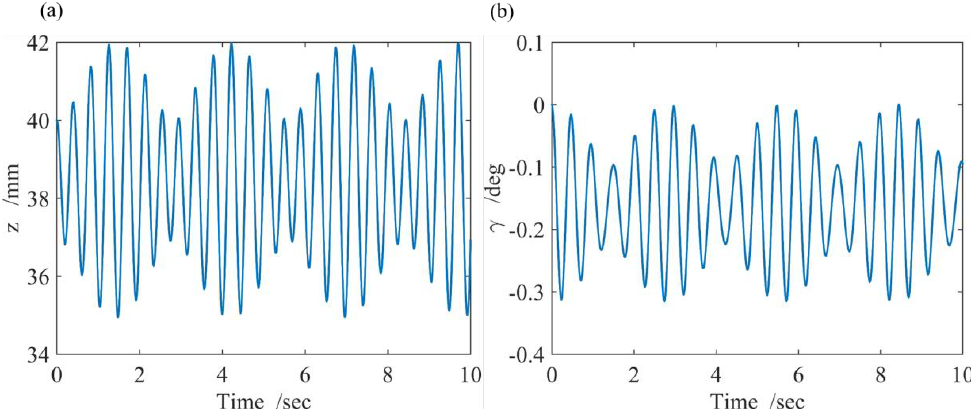
Figure 9. The ( a ) z ( t ) and ( b ) γ ( t ) of the vehicle based on multi-body dynamics when v = 14 mps, MMF = 310 kAt, and z ( 0 ) = 40 mm.